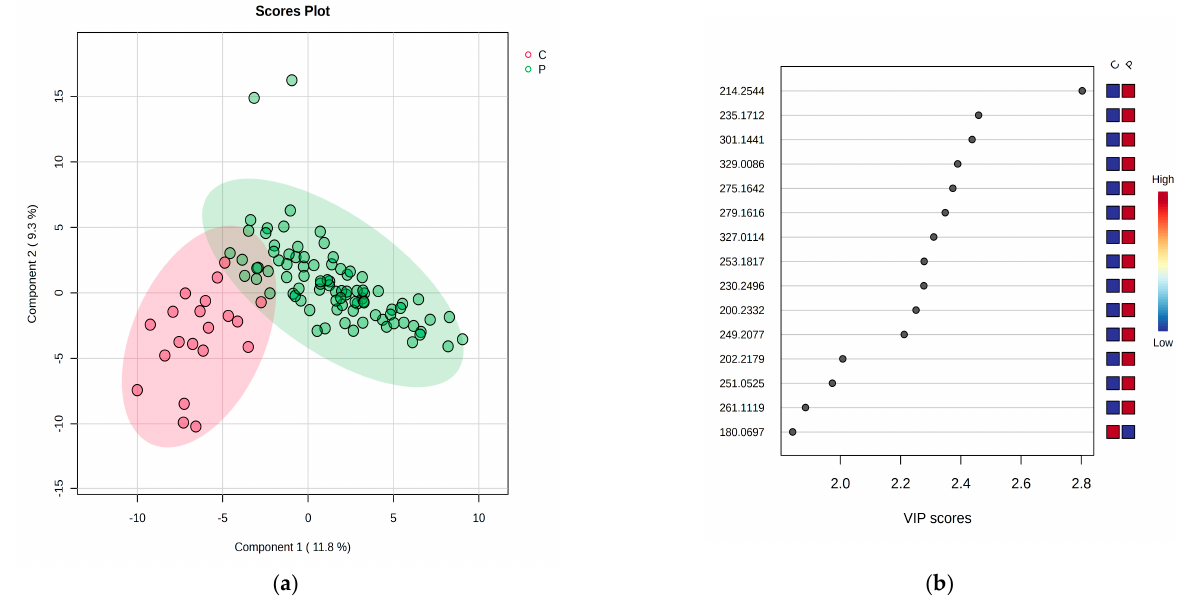
Figure 3. ( a ) The PLSDA score plot highlights the good discriminations between the C group and group P for urine samples. ( b ) VIP values and ranking of top 15 molecules according to PLSDA analysis. Table 3. The m/z values for the most significant metabolites from urine samples and their identifica- tion according to the HMDB database. These metabolites were considered predictive given their VIP and MDA